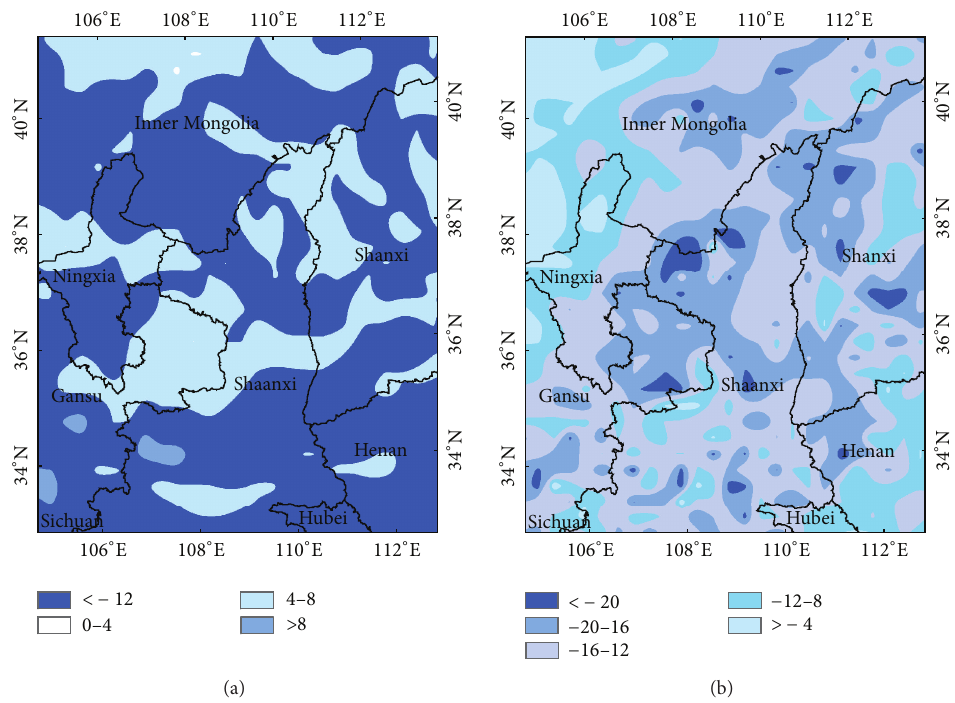
Figure 7: Difference in the annual precipitation (unit: mm) in the winter (a) and summer (b) from 2010 to 2040 in overgrazing areas of Northwest China between the sensitivity test and control